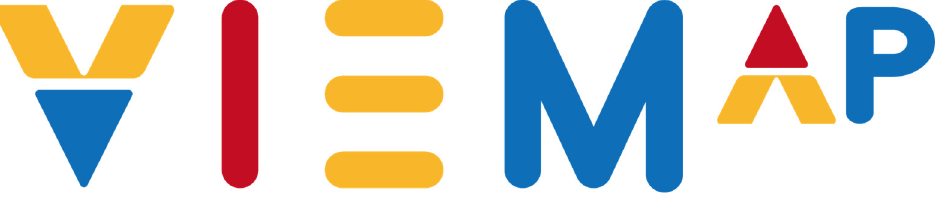
Table 1. Capabilities of VIEMAP.